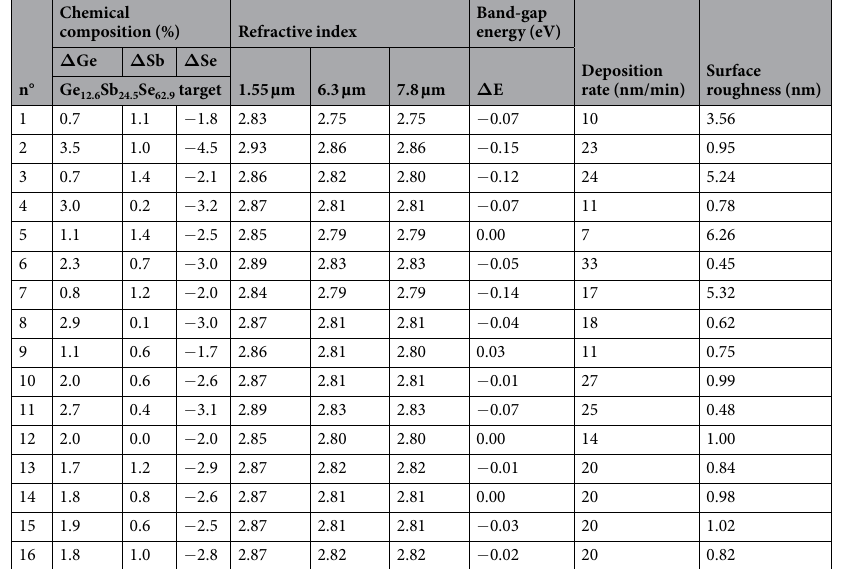
Table 4. Experimental results for the Ge 12.5 Sb 25 Se 62.5 thin films (chemical composition, refractive index, band- gap energy and surface